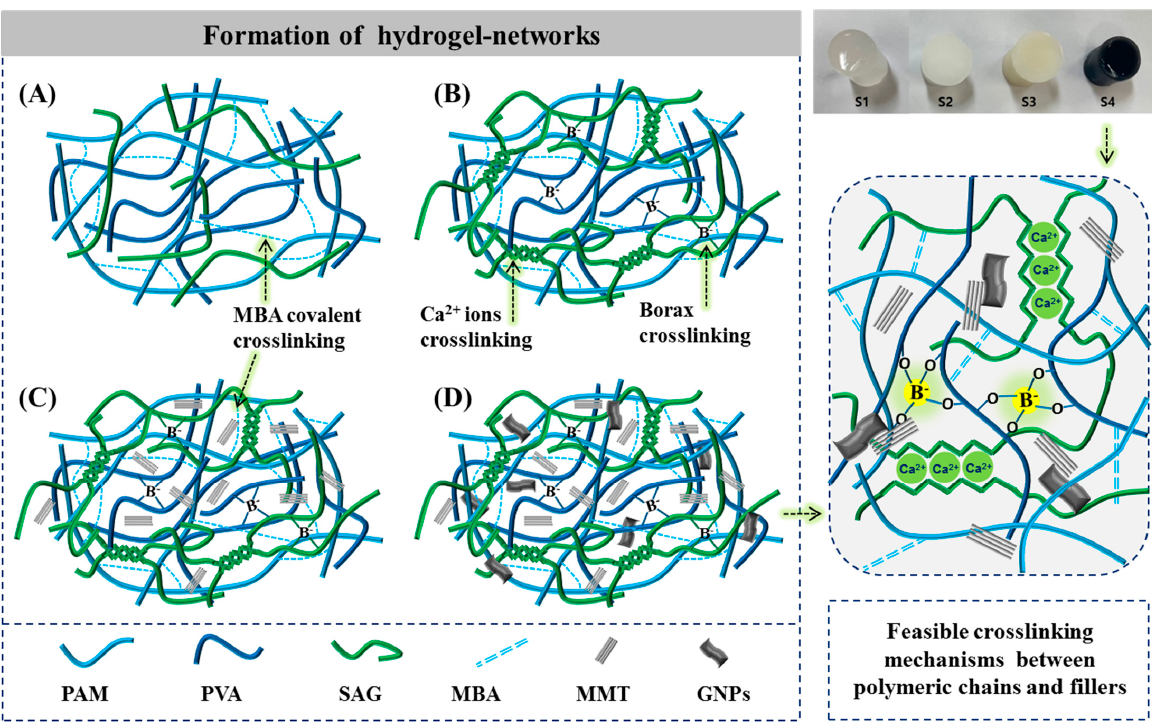
Figure 1. Schematic illustration of the formation of hydrogel networks: ( A ) PAM-g-(PVA/SAG); ( B ) PAM-g-(PVA/SAG)/BX/Ca 2+ ; ( C ) PAM-g-(PVA/SAG)/BX/Ca 2+ /MMT; and ( D ) PAM-g- (PVA/SAG)/BX/Ca 2+ /MMT-GNPs) designated as S1, S2, S3, and S4, respectively. ( * Hydrogen bond- ing is not shown here).